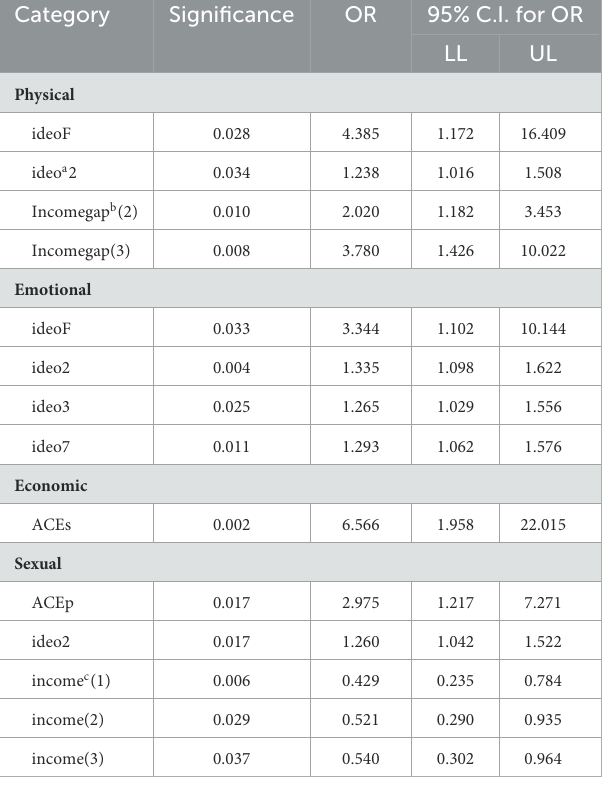
TABLE 8 Binary regression analysis result: all income groups